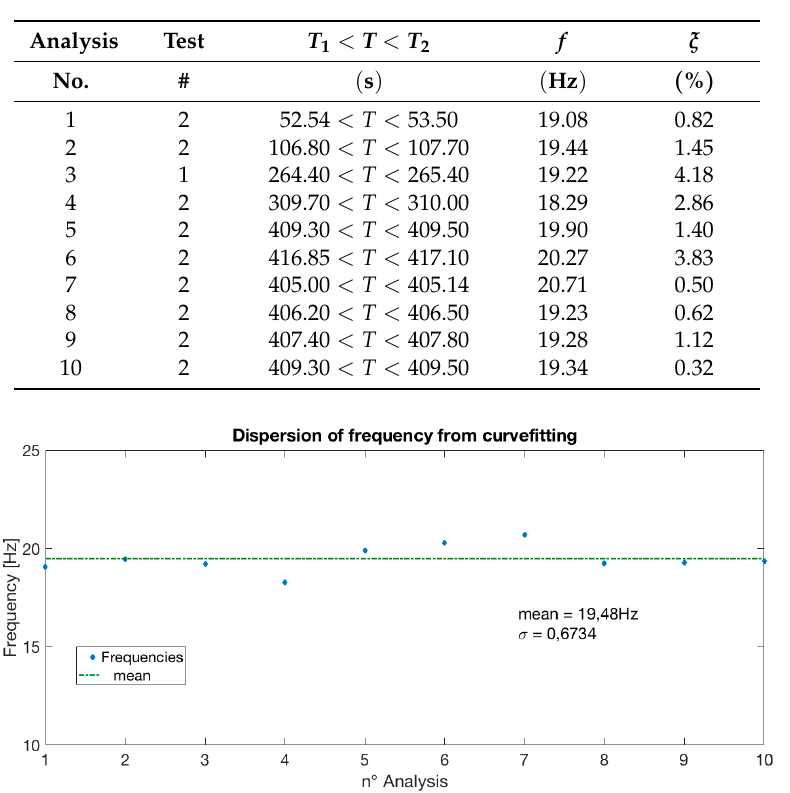
Table 2. Curvefitting experimental signal.